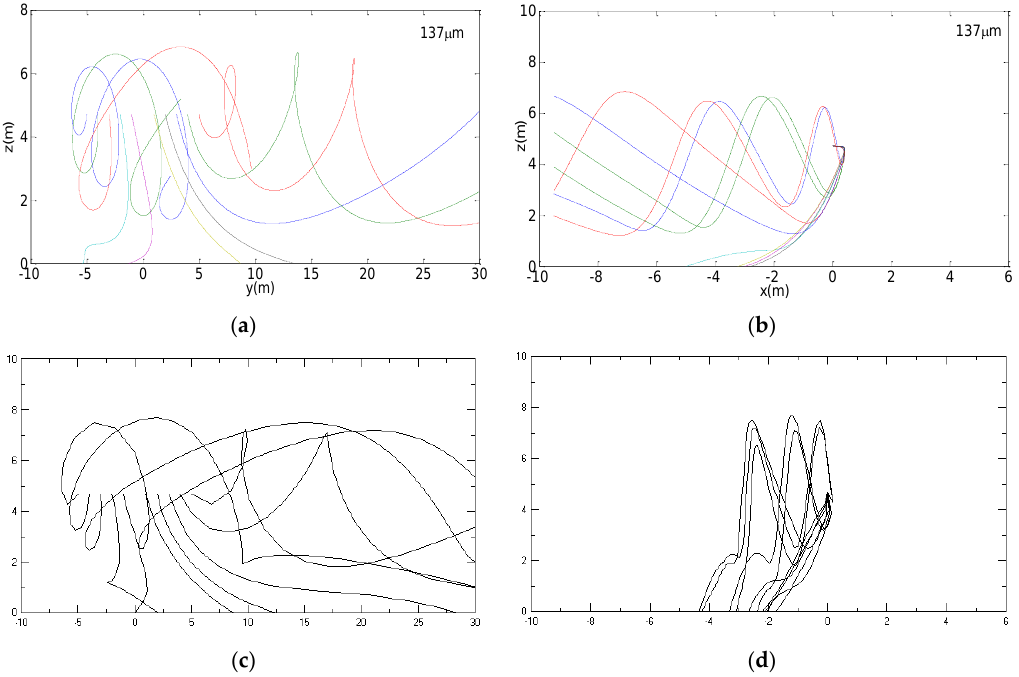
Figure 18. Comparisons of trajectories of 137 μm droplets in the IGE model and AGDISP from two views. Two respective figures in the up (IGE model) and down (AGDISP) have the same scale and unit of measure: ( a ) yz plane (rear view of an aircraft) based on IGE model; ( b ) xz plane (right view of an aircraft) based on IGE model; ( c ) yz plane (rear view of an aircraft) based on AGDISP; ( d ) xz plane (right view of an aircraft) based on AGDISP.